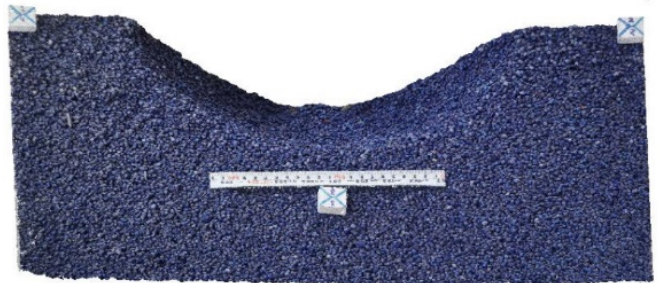
Figure 9. Dense point cloud of flushing cone for Test no. 3, Case study III.